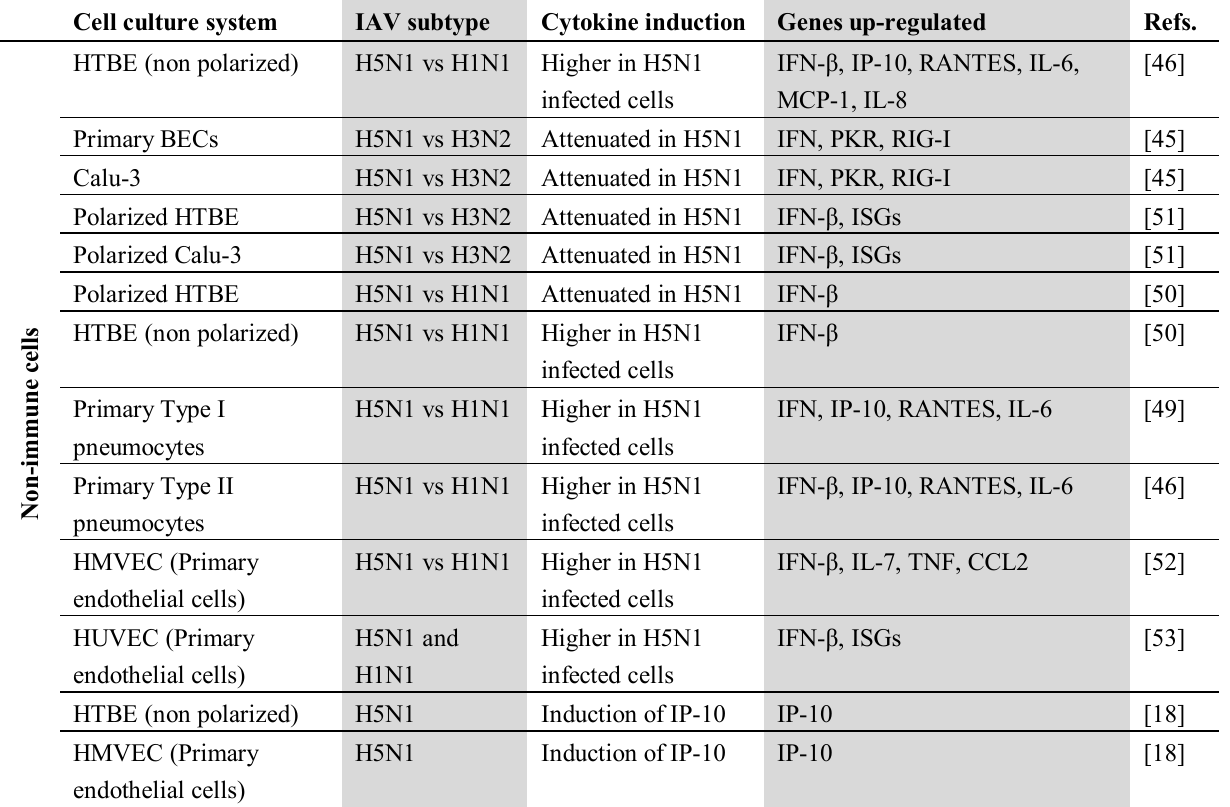
Table 1. Summary of cytokine induction by avian H5N1 IAV and comparison with H3N2 and H1N1 human IAV in human cell experimental models.